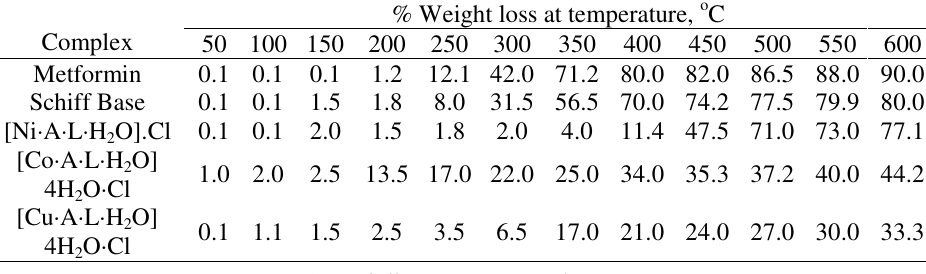
Table 3 . Cumulative % weight loss data of metal complexes at various temperatures ( O C) from thermogram